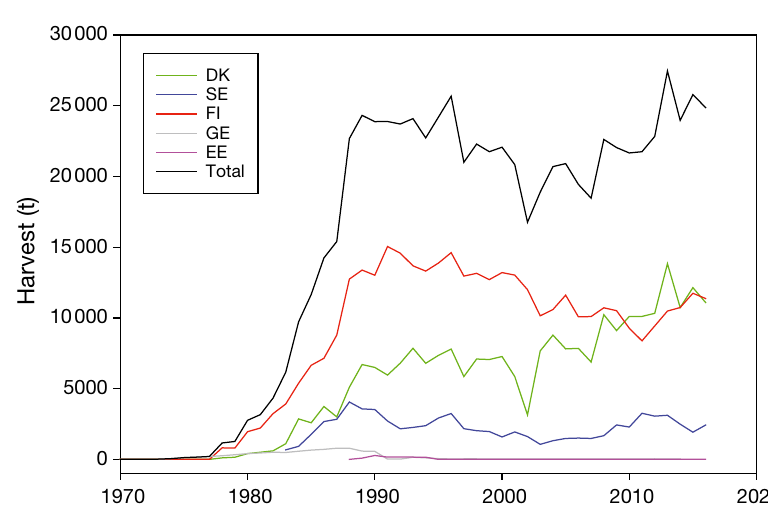
Fig. 1. Annual harvest of rainbow trout from marine aquaculture over time in the Baltic Sea. DK: Denmark; SE: Sweden; FI: Finland; GE: Germany; EE: